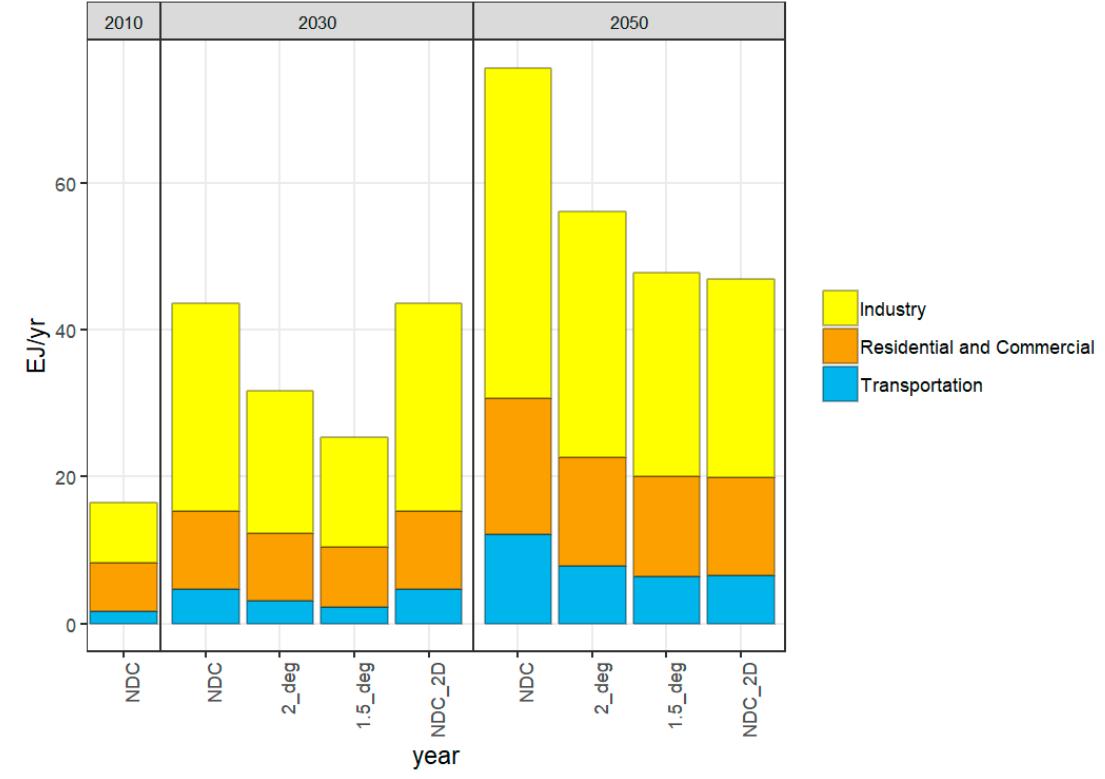
Figure 7. Final energy demand in different scenarios.